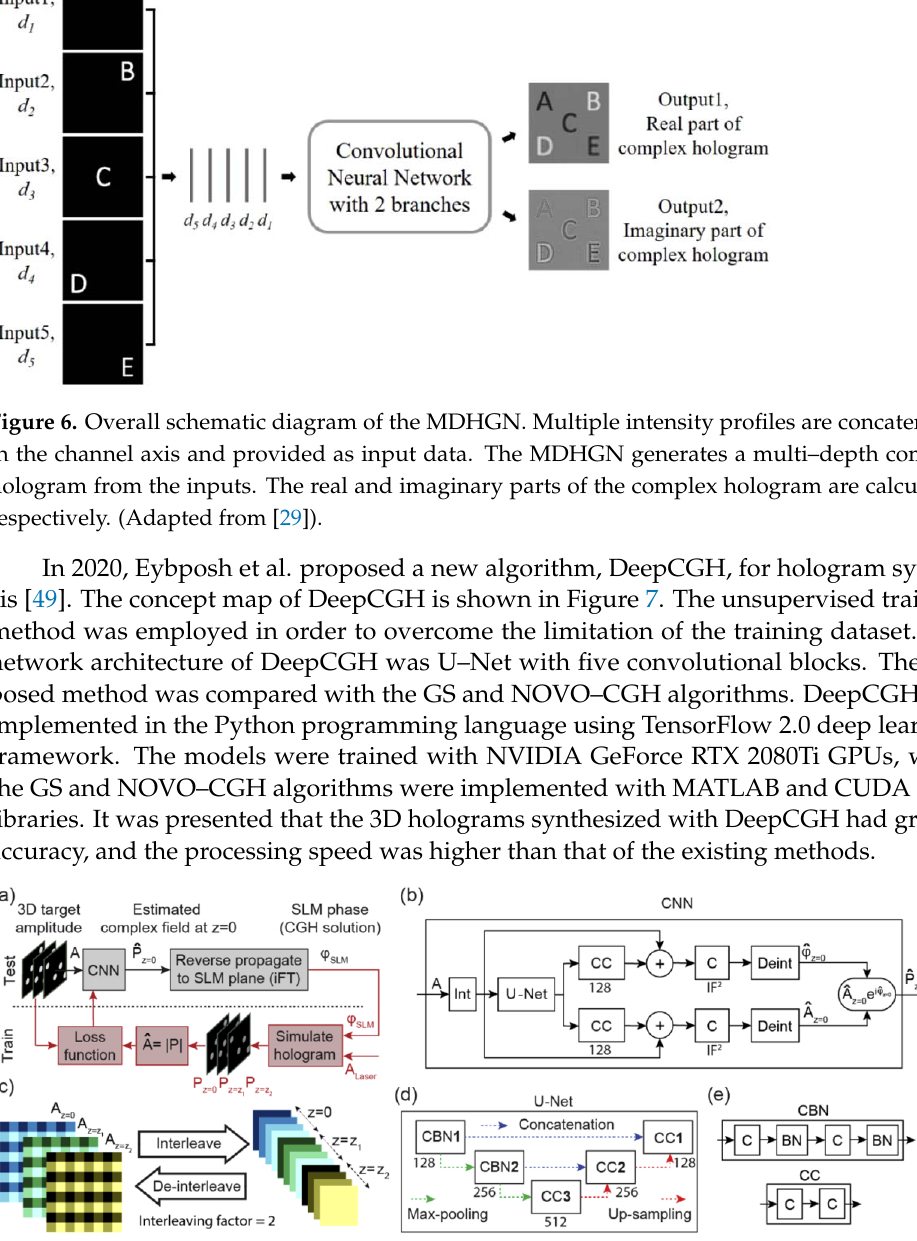
Figure 7. ( a ) Trained CNN estimates the complex field in the image plane. ( b ) CNN structure for DeepCGH. ( c ) The interleave module and the de − interleave module. ( d ) The U − Net model contain ‐